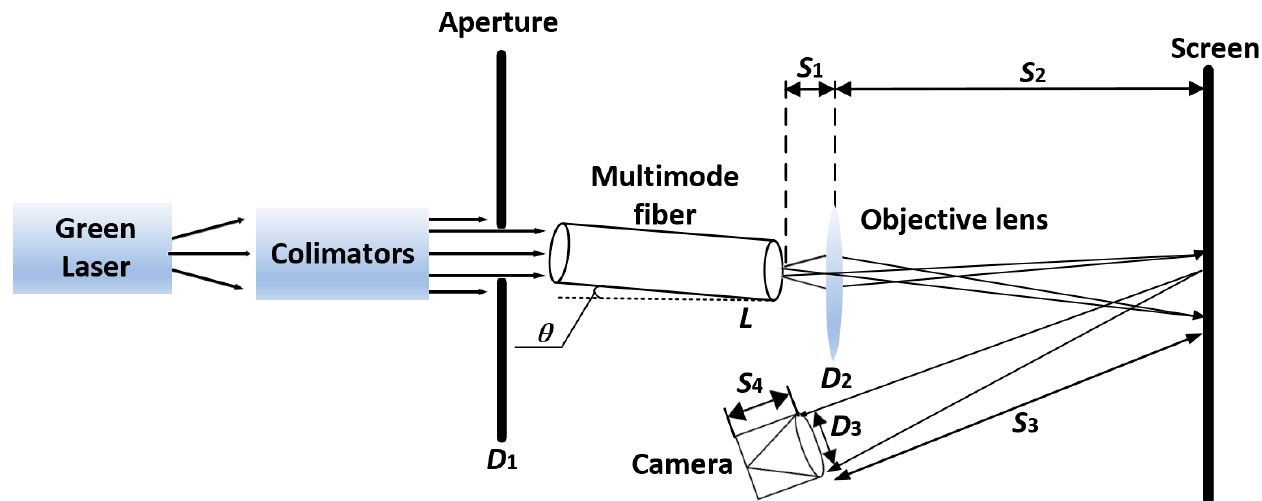
Figure 3. The experimental setup based on the speckle contrast at the output of a multimode fiber under various excitation conditions (by varying the tilt angle of the Gaussian beam to θ = 0.2°, 0.5°, and 1°). Here, D 1 = 1.3 mm, S 1 = 60 mm, D 2 = 50 mm, S 2 = 1800 mm, D 3 = 1 mm, S 3 = 1000 mm, and S 4 = 25 mm.